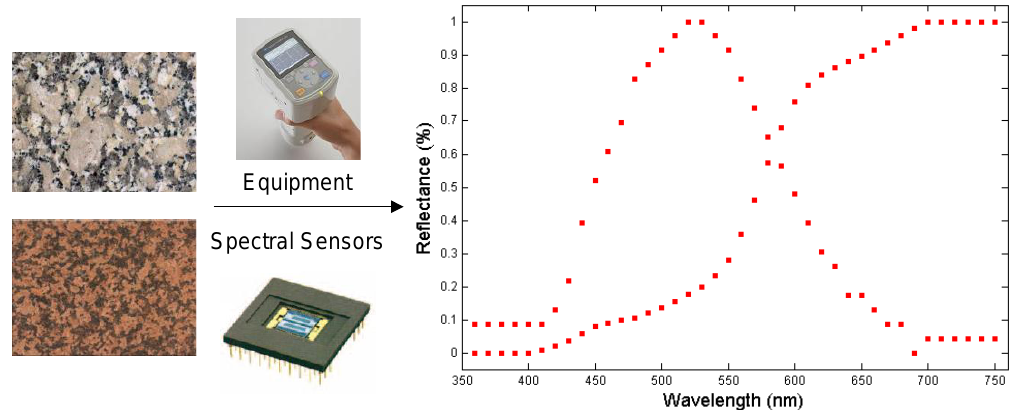
Figure 1. Vectorial spectral information captured for two granite specimens for 40 points corresponding to the visible area of the